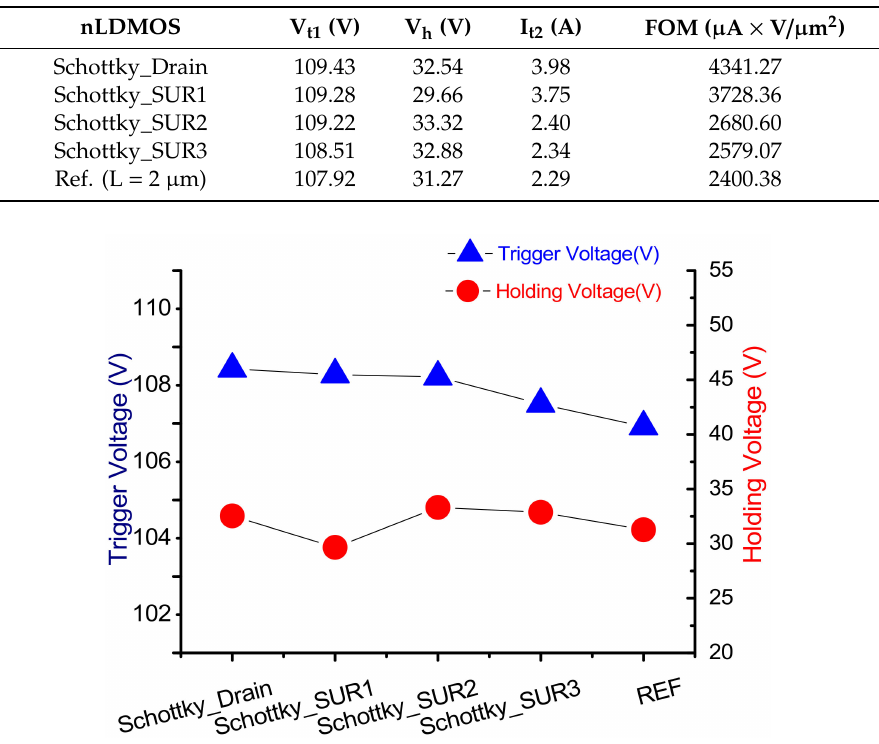
Figure 19. Trigger voltage / holding voltage distribution charts of HV nLDMOSs with embedded Schottky-diode